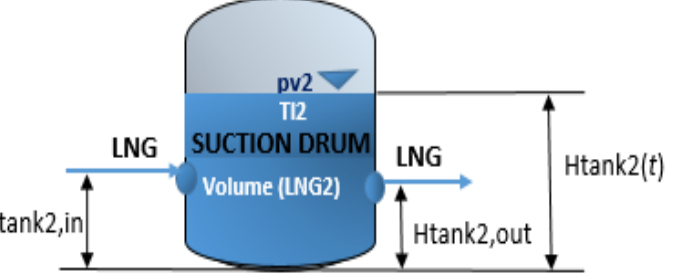
Figure 4. LNG level observation in the Suction Drum.